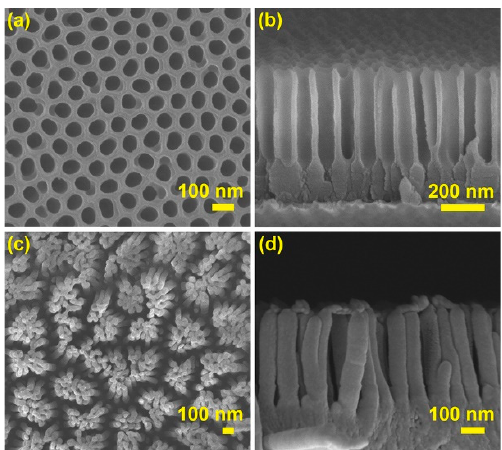
Figure 3. ( a , b ) SEM images of the AAO template with nanohole period of ∼ 100 nm. ( c , d ) SEM images of the polymer replica.